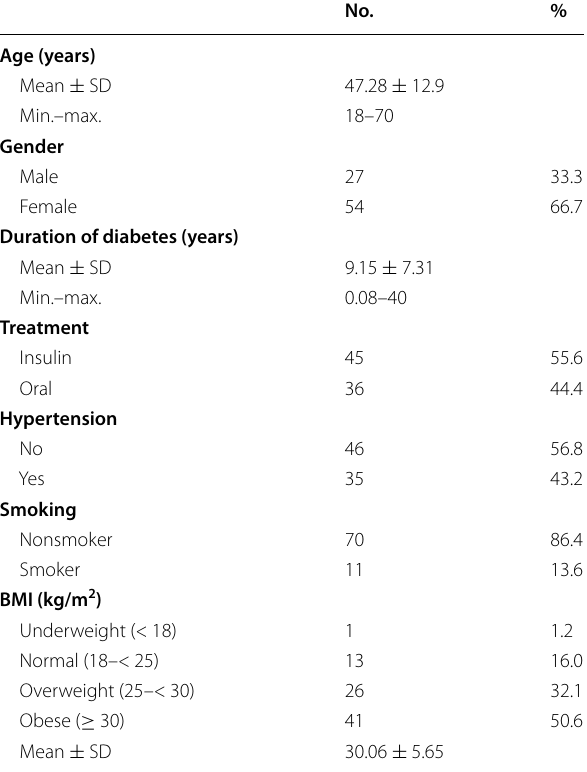
81) Table 2 Distribution of the studied patients according to = neuropathy assessment ( n =